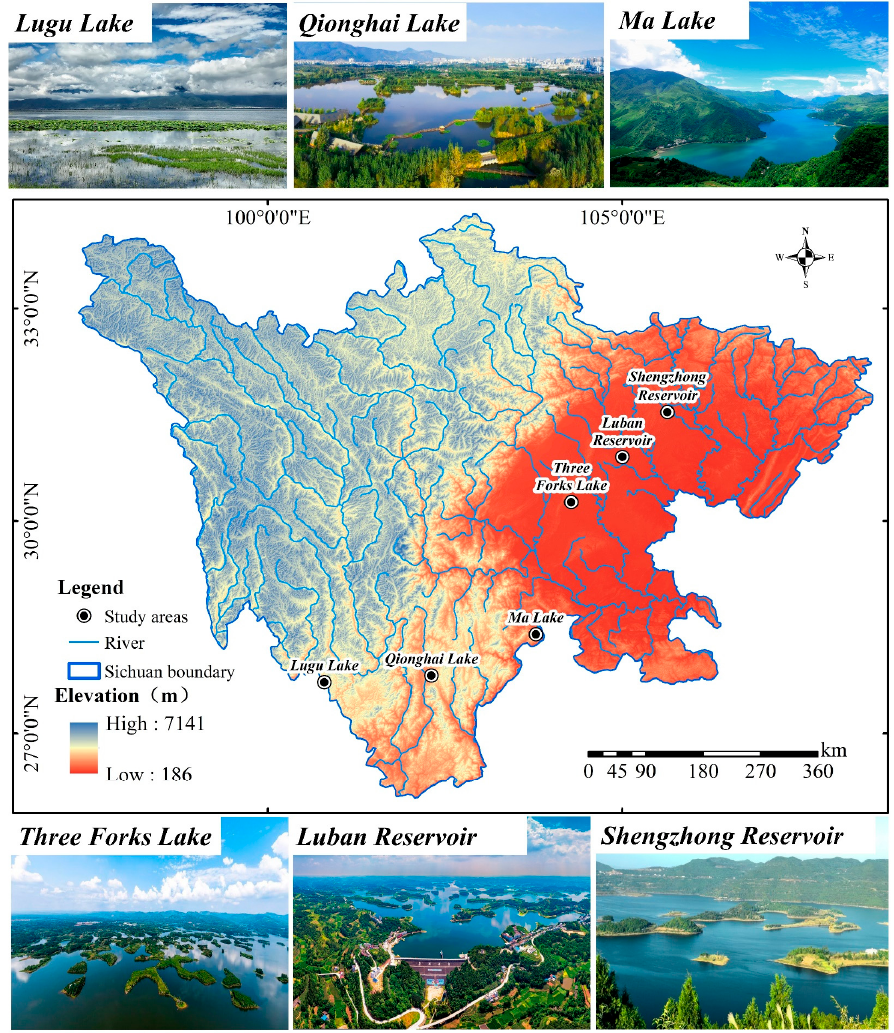
Figure 1. Locations of the lakes in the study area.